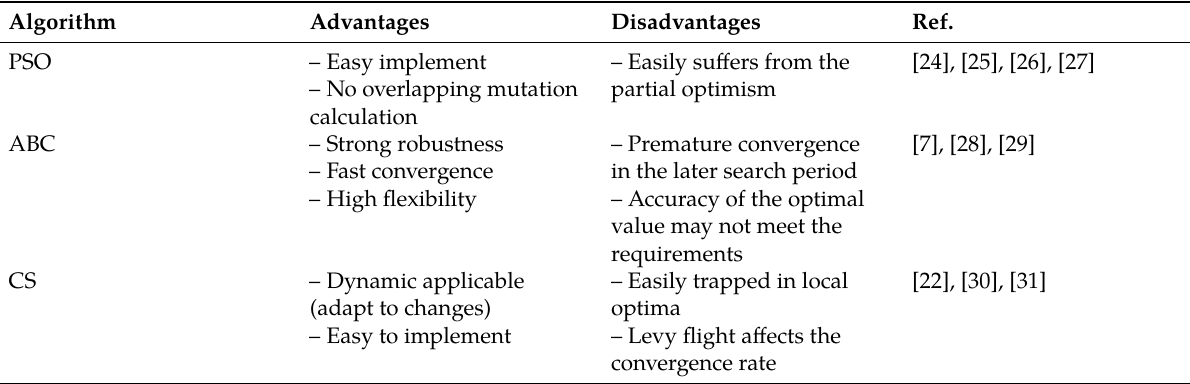
Table 1: Comparisons of metaheuristic algorithms.